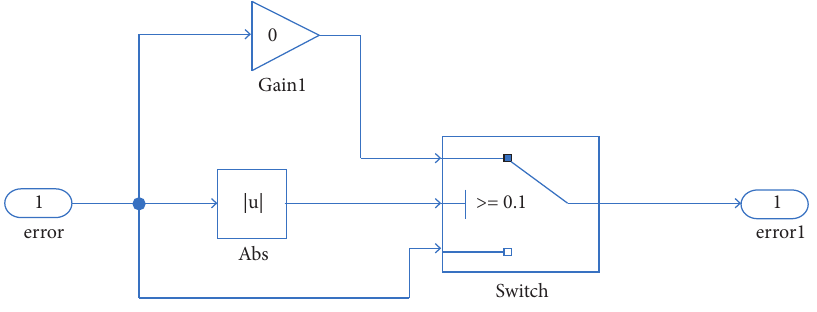
Figure 3. Integral-separation PID